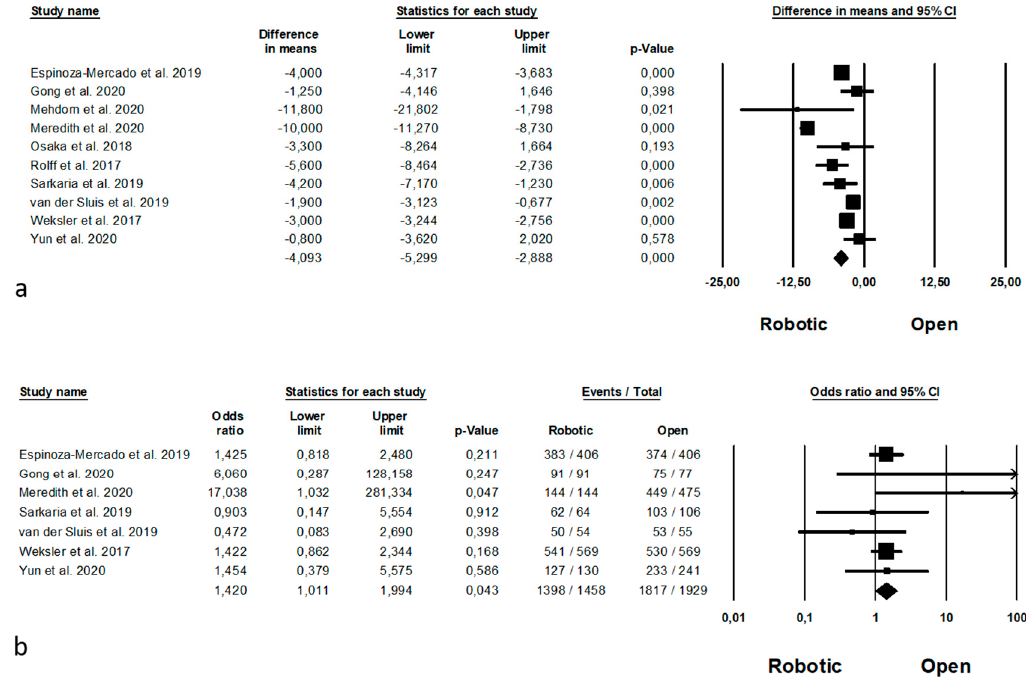
Figure 9. Robotic versus open surgery: oncologic outcomes. ( a ) number of harvested nodes; ( b ) R0 resection.